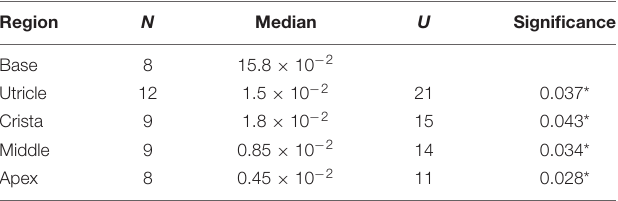
TABLE 2 | Relative expression of SCN5A in base of cochlea compared to other inner ear regions at 14 + WG. Region N Median U